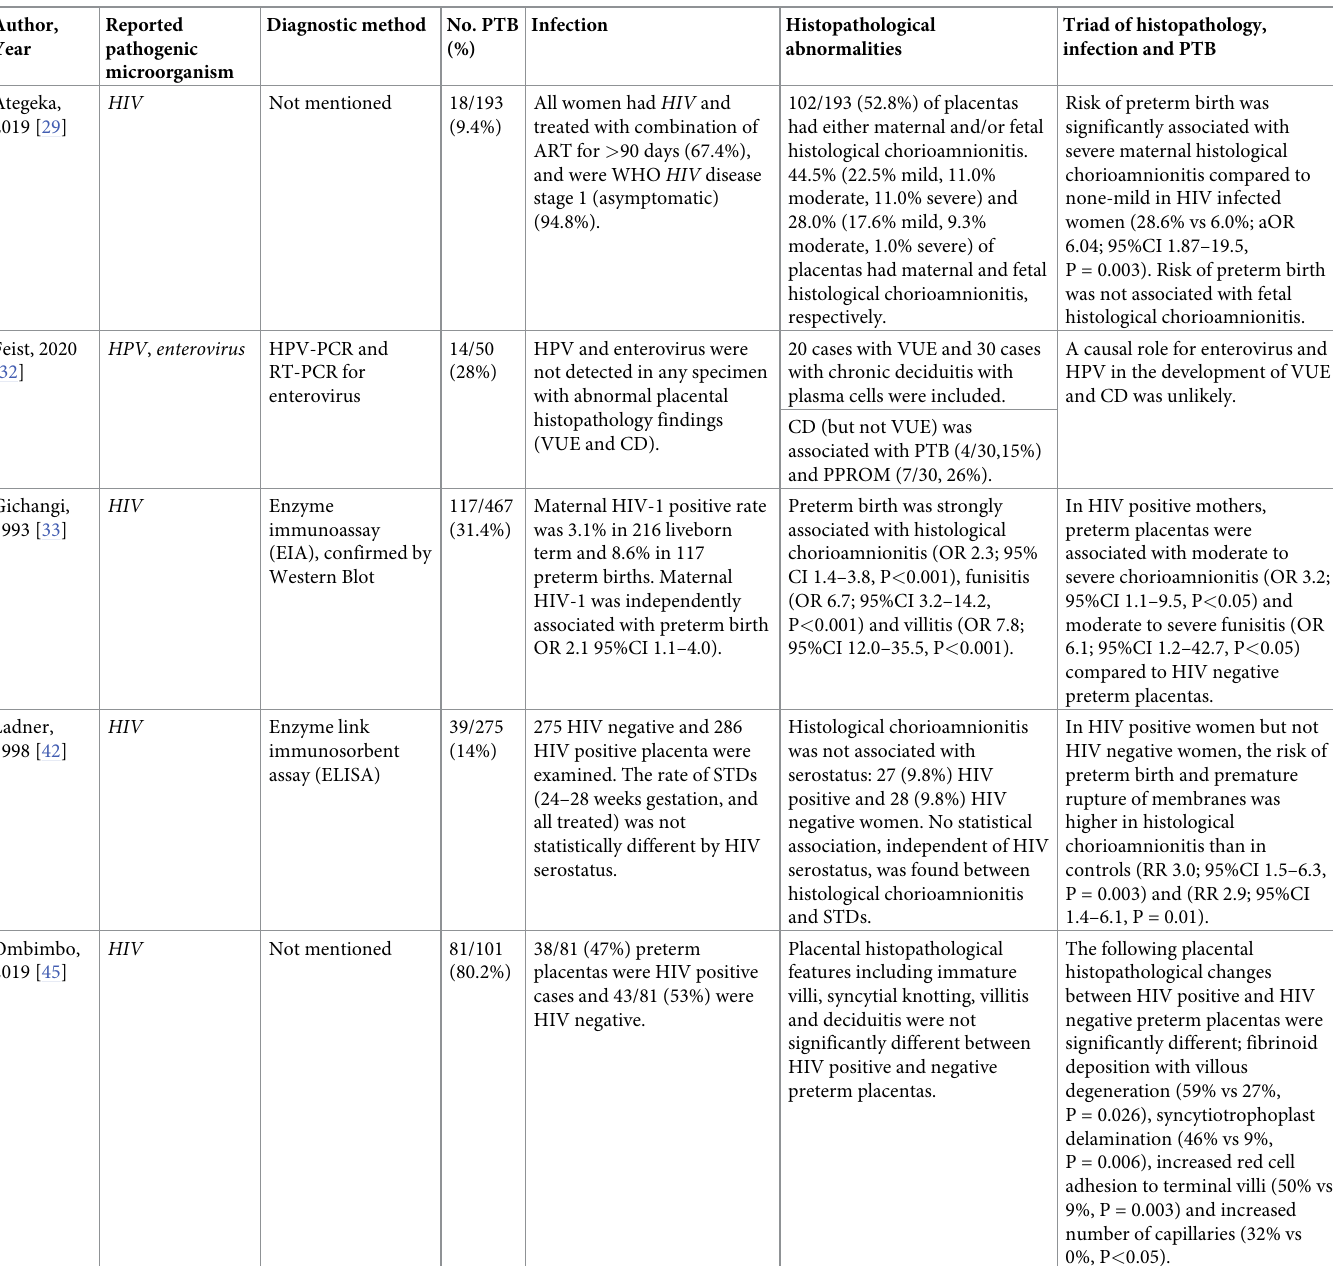
Table 3. Identified viral infection and histopathological changes in preterm